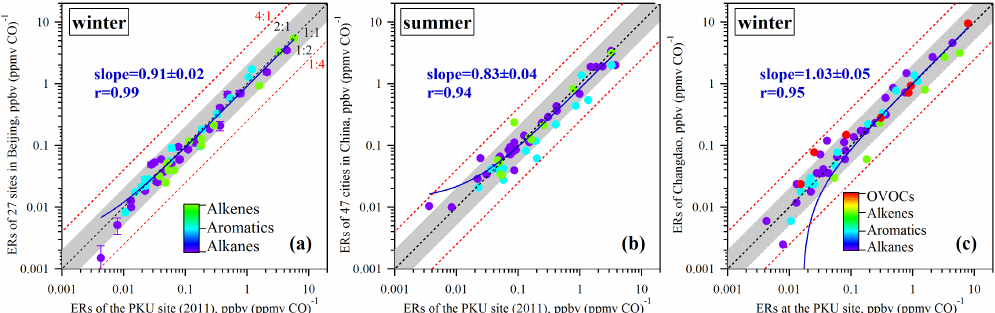
Figure 8. Comparisons of VOC emission ratios determined at the PKU site with those determined from (a) regional measurements at 27 sites in Beijing, (b) 47 cities in China (Wang et al., 2013), and (c) the Changdao site in China (Yuan et al.,